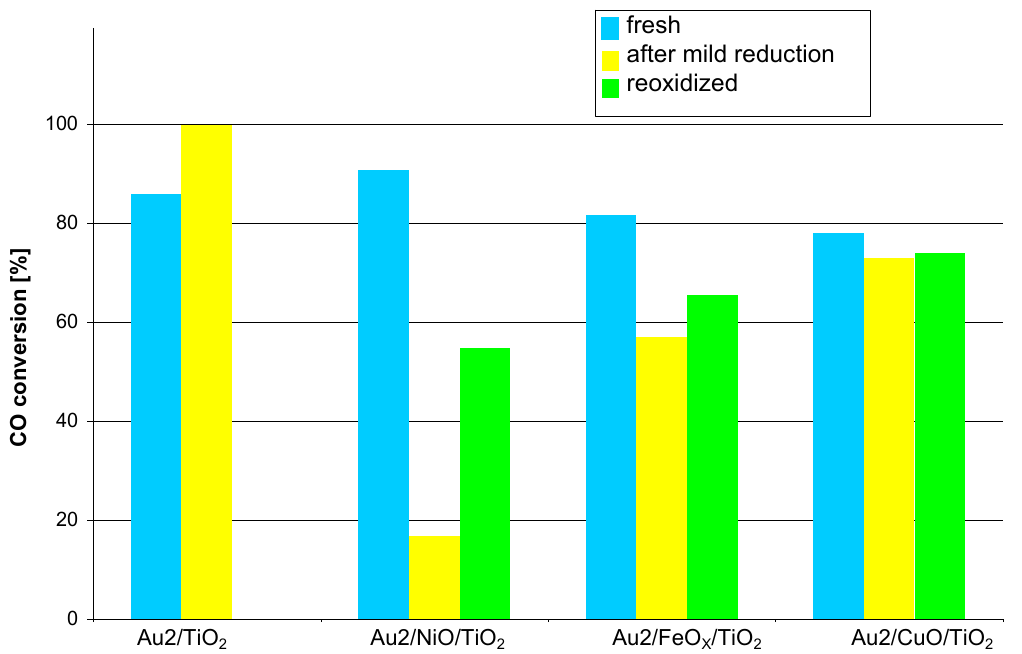
Figure 3. Catalytic activity at 35 °C measured for catalysts obtained by deposition of metal oxides (Ni, Fe, Cu) on TiO before gold nanoparticle deposition. Reaction conditions: 2 contact time: 0.36 s, feed composition: CO:O :He ≈ 2